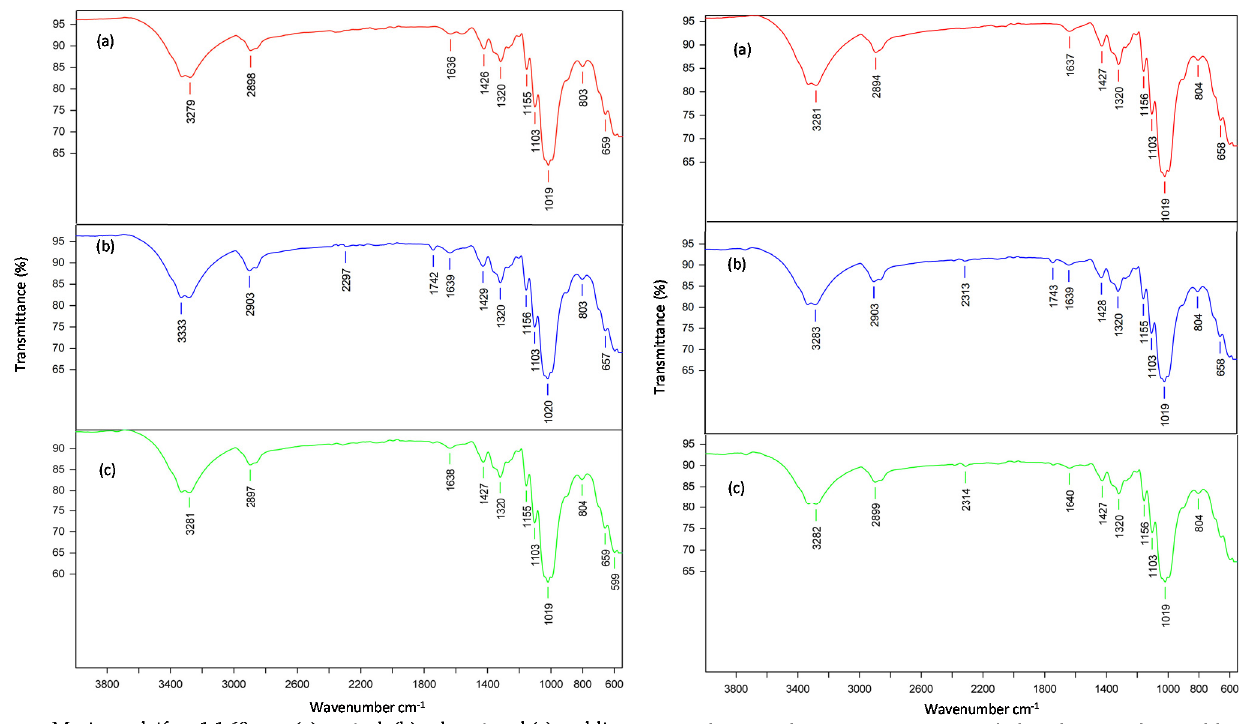
Figure 9. FTIR for Moringa oleifera and Aegle marmelos 20 gsm fabrics.